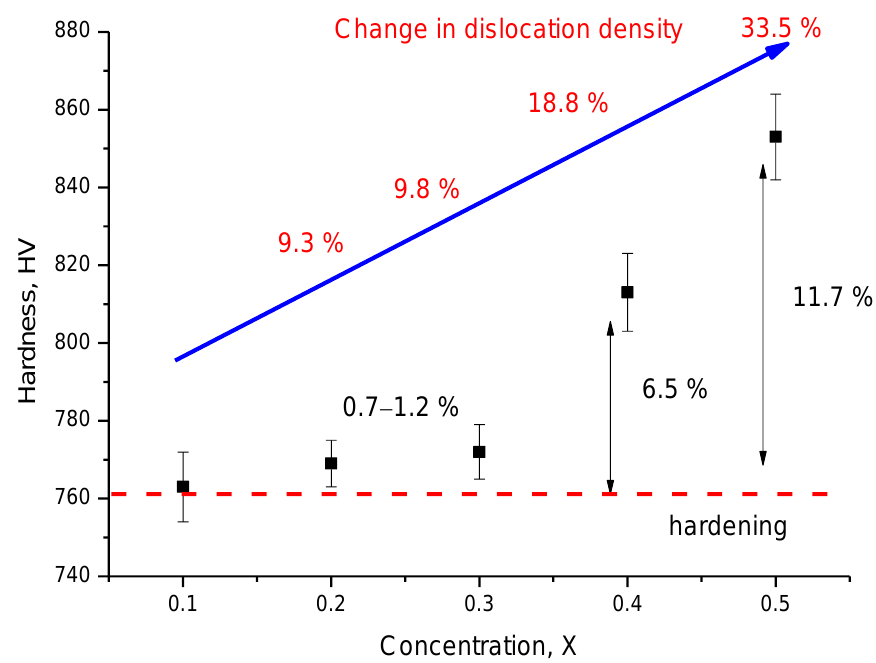
Figure 6. Ceramic hardening results depending on the concentration of component X.